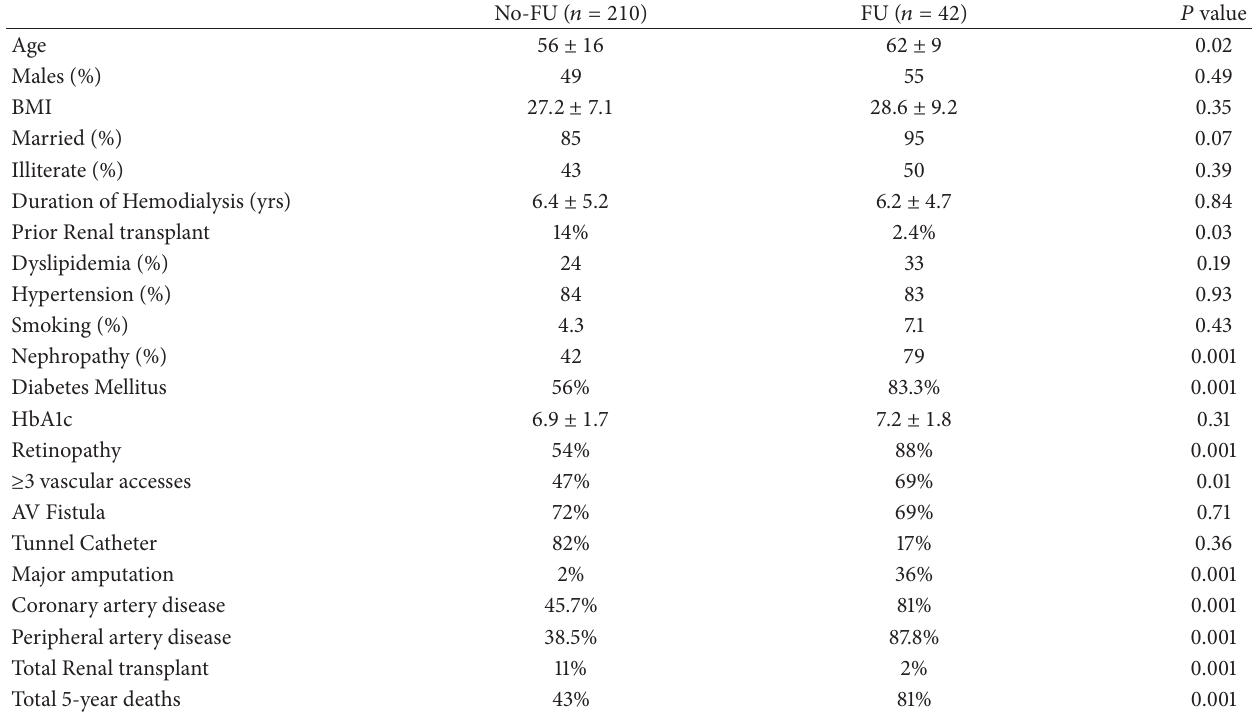
Table 1: Foot ulcer in hemodialysis patients ( 𝑛 = 252 ).